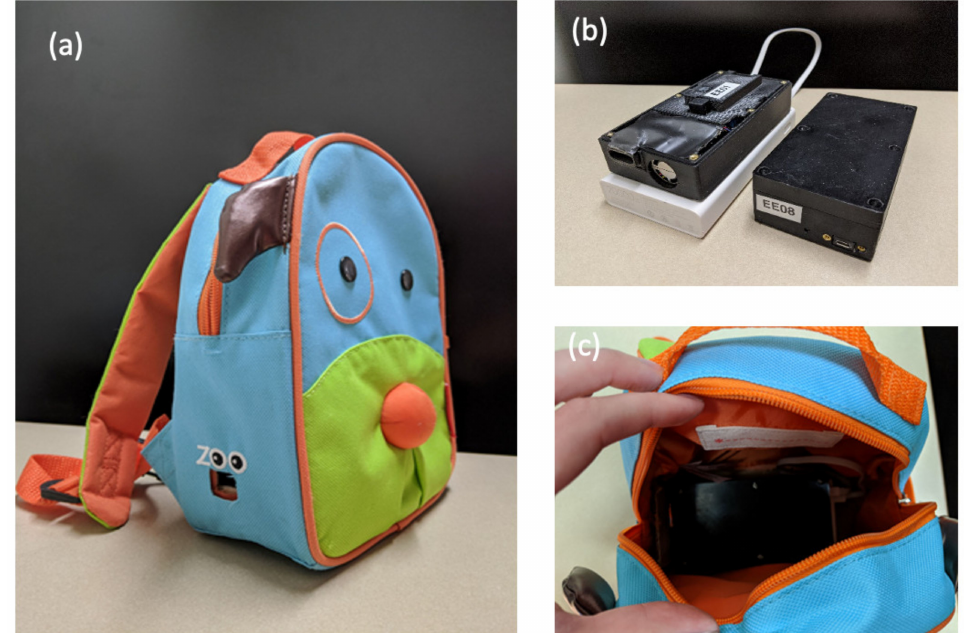
Figure 3. Photographs of the ( a ) exterior of backpack shown with inlet hole aligning with personal air sampler inlet; ( b ) PLANTOWER PM5003 air sampler with mobile battery pack ( left ) and with case securely fastened by screws ( right ) ( c ) PLANTOWER PM5003 personal air sampler and battery pack secured in child’s